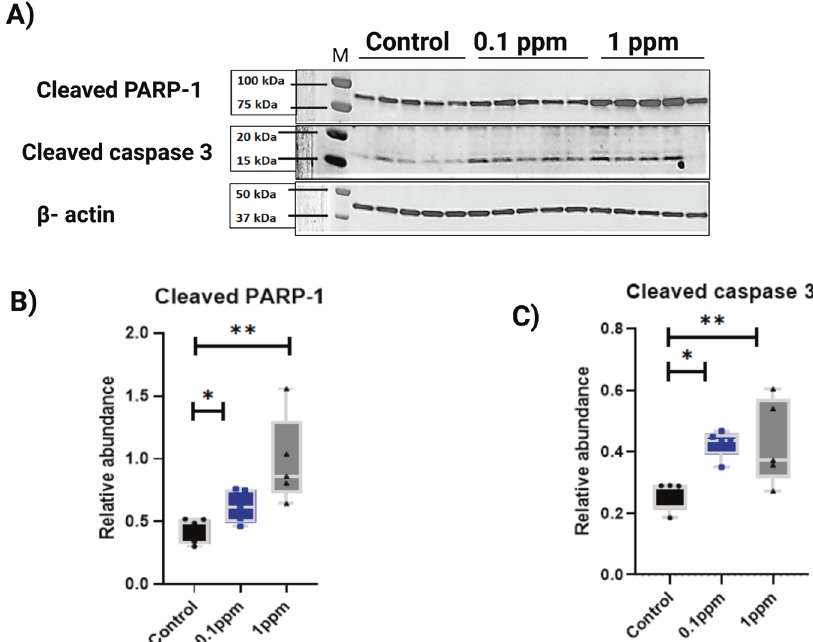
Fig. 3 Western blot validation of the apoptotic biomarkers. A Representative Western blot of striatal homogenate from control, 0.1 ppm group and 1 ppm groups show a signi fi cant difference in the protein level of cleaved PARP 1 (molecular weight-89) and cleaved caspase 3 (molecular weight-17) in the striatum of 0.1 ppm and 1 ppm group as compared with the control group. The quantitative analysis is shown in B for cleaved PARP 1 and in C for cleaved caspase 3 in all groups. The data are presented as mean values ±SEM ( n = 5). Two-tailed t -tests was